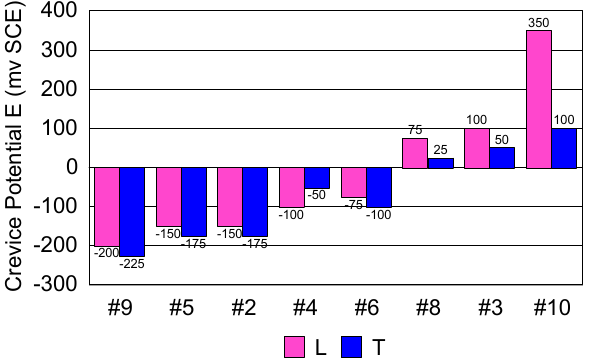
Figure 13. Crevice potential values measured for the transverse and longitudinal surfaces of the steels considered (L: longitudinal, T: transverse).